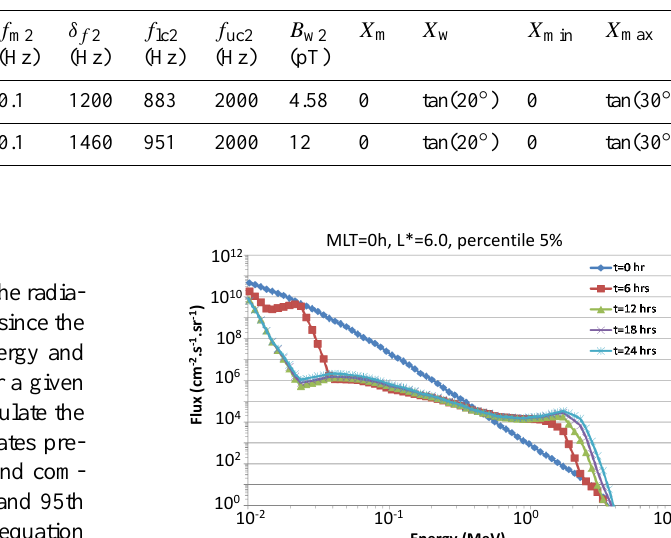
Table 1. Hiss waves parameters used in this study.